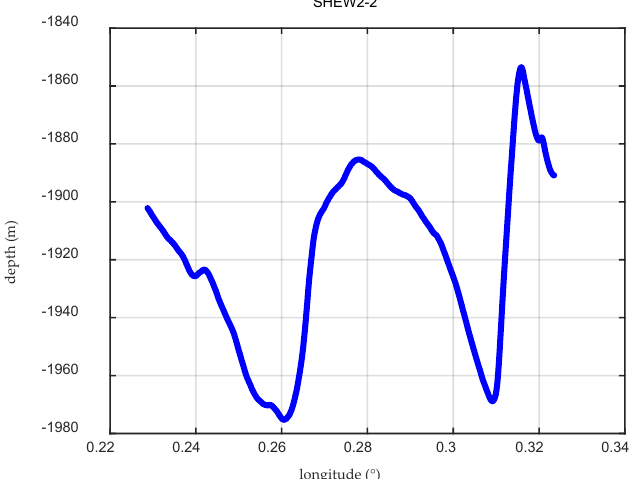
Figure 2. Depth curve of SHEW2-2.